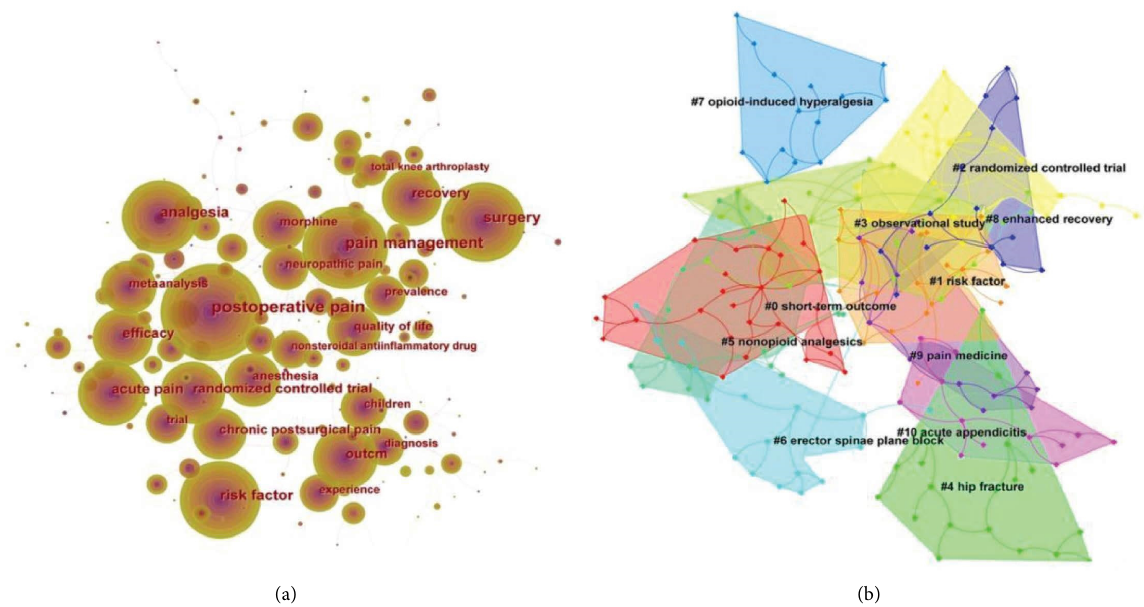
Figure 9: Te (a) co-occurrence and (b) clustering of keywords in publications on acute postsurgical pain,